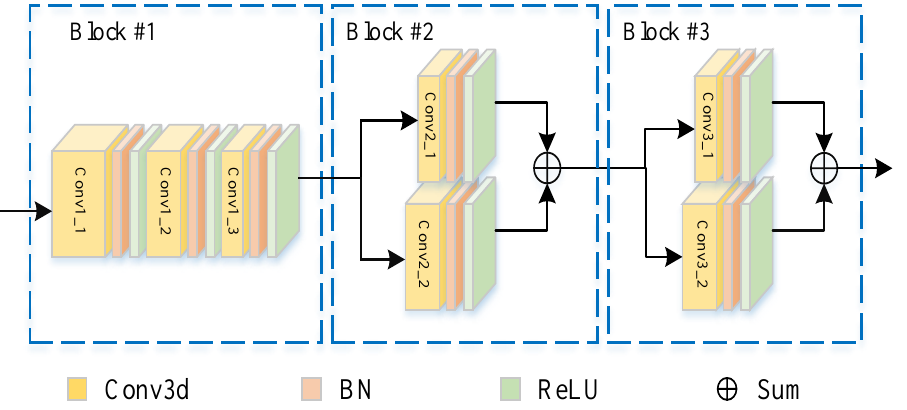
Figure 3. The Siamese network’s structure. The Siamese network includes the backbone and informa- tion transmission parts.